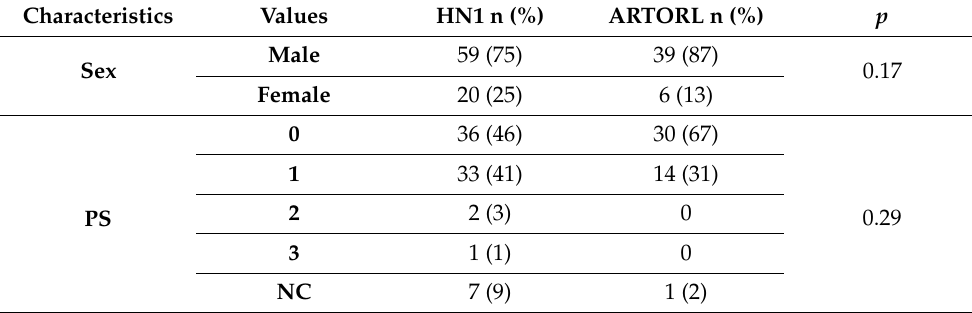
Table A1. Patients’